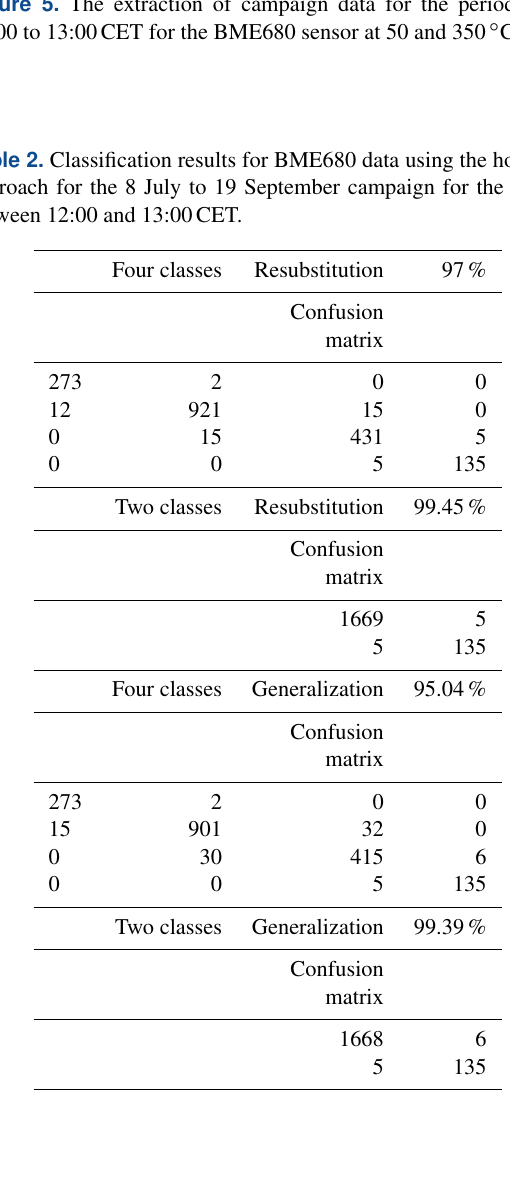
Figure 6. A phase space example of campaign data for the BME680 sensor at 50 ◦ C and the four classes of VILE.